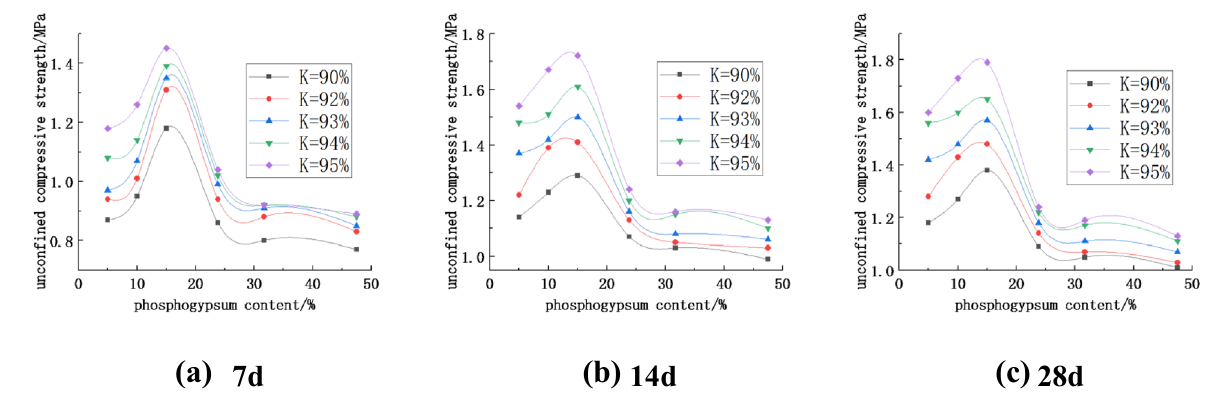
Fig. 2 Relationship curve between unconfined compressive strength and phosphogypsum content of mixture at different ages (5%